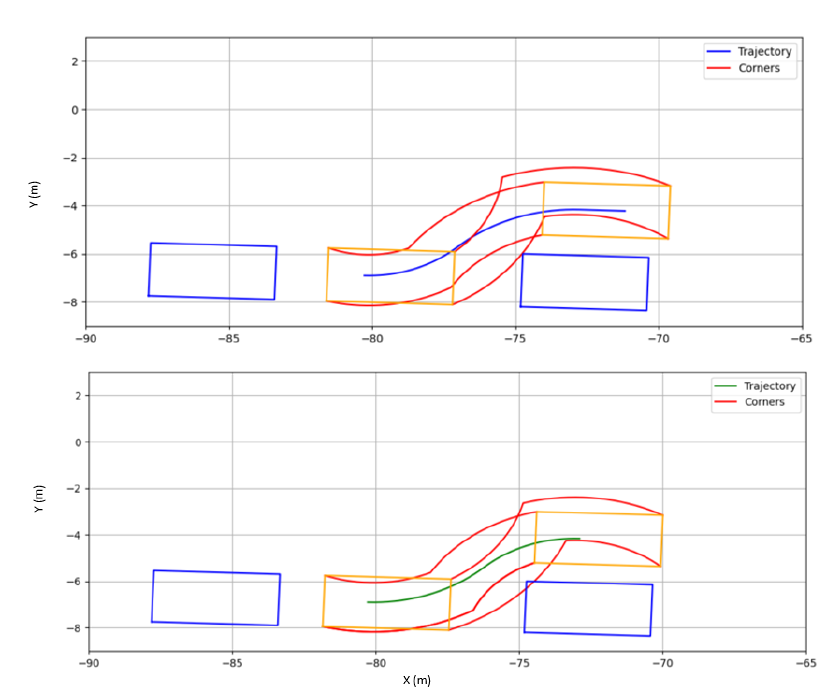
Figure 10. Parallel parking collision check. Up: A valid trajectory. Down: a not valid trajectory. Blue boxes represent parked vehicles. Orange boxes represent the vehicle to be parked. Red lines represent the limits for the parking process, in order to detect collisions.